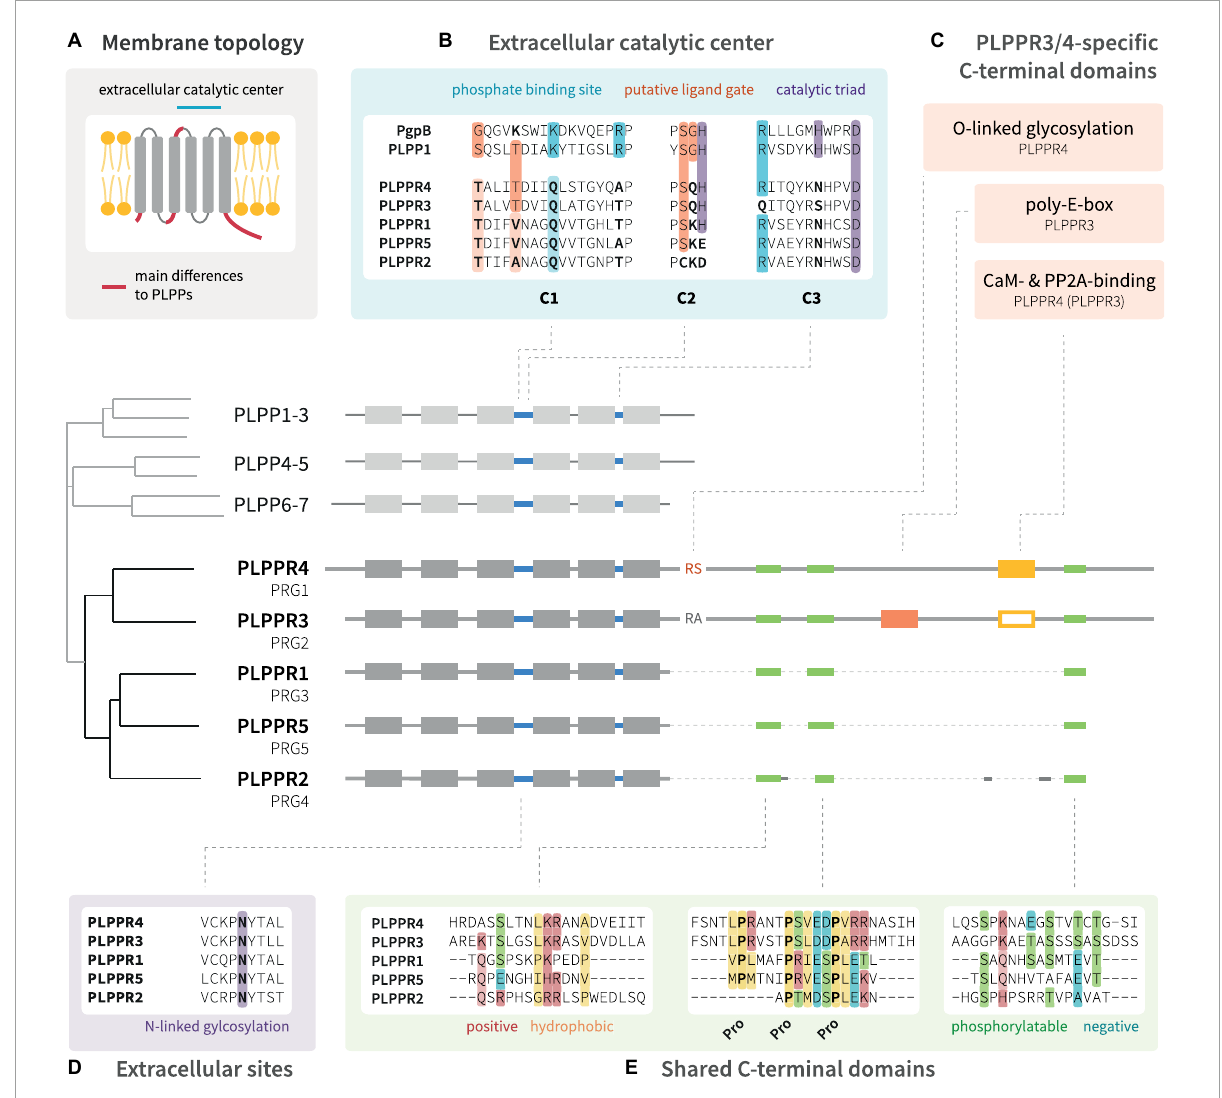
FIGURE1 Domain structure of PLPPR family proteins. (A) PLPPRs are transmembrane proteins with six membrane-spanning domains; both the N-terminus and C-terminus are localized in the cytosol. (B) The extracellular catalytic center of PLPPRs shares some homology with PLPPs, but differs in critical catalytic and phosphate-binding residues. (C) PLPPRs differ from PLPPs in their C-terminus and cluster into a group of long-tail PLPPRs (PLPPR3, PLPPR4) and a group of short-tail PLPPRs (PLPPR1, PLPPR2, PLPPR5). PLPPR4 contains a cytosolic O -linked glycosylation site, and calmodulin and PP2A binding sites. The calmodulin and PP2A binding site is also found in PLPPR3 but has not been validated. The PLPPR3 sequence encompasses an unusual stretch of 20 glutamic acids. (D,E) All PLPPRs share an extracellular N -linked glycosylation site, a short sequence of positive and hydrophobic aa, a charged proline motif and a cluster of phosphorylation sites. Alignments as well as the cladogram were generated with UniProt sequences of mouse PLPPRs or PLPPs using the MAFFT algorithm available at EMBL-EBI